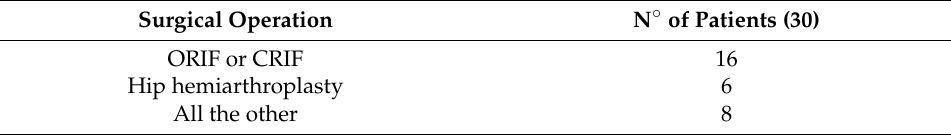
Table 2. Type of surgical operation.